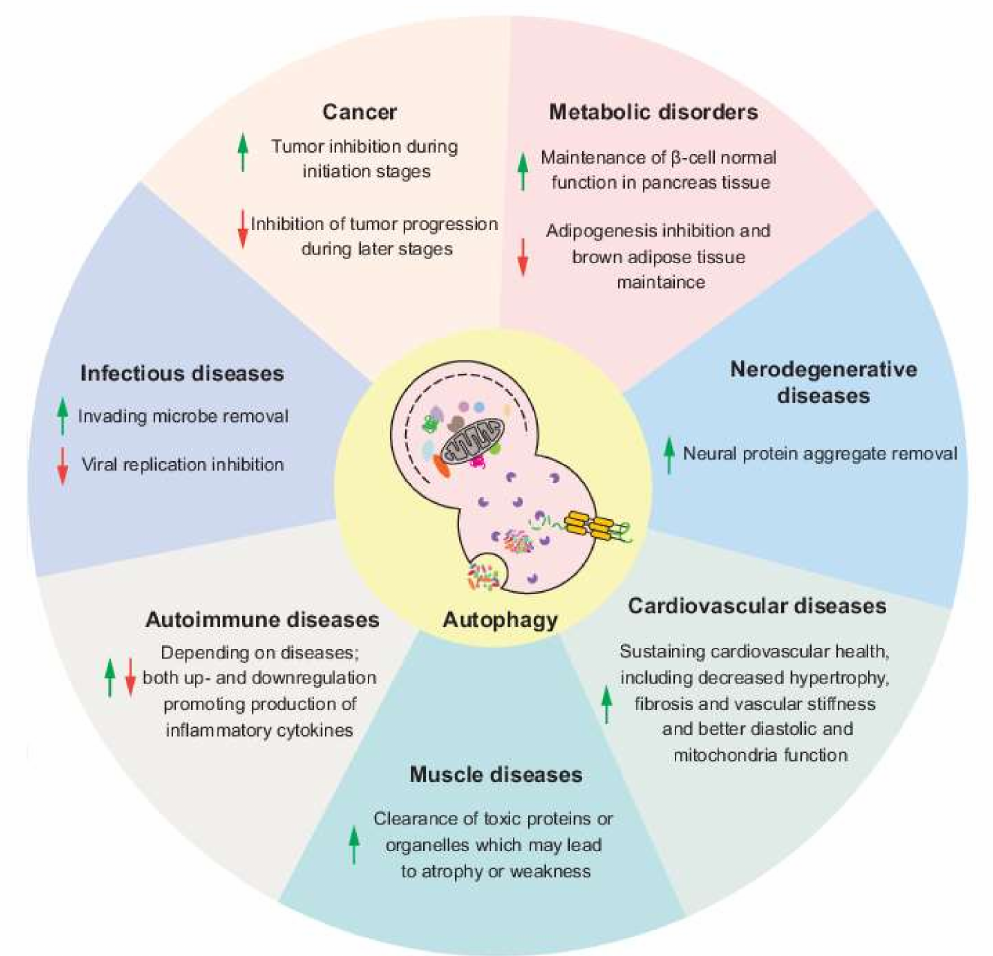
Figure 4. Potential effects of autophagy modulation in different human diseases. Arrows indicate the upregulation or downregulation of autophagy. Because the role of autophagy within one particular disease may be complicated and there are typically studies with controversial conclusions, we only summarize the effect reported from the majority of